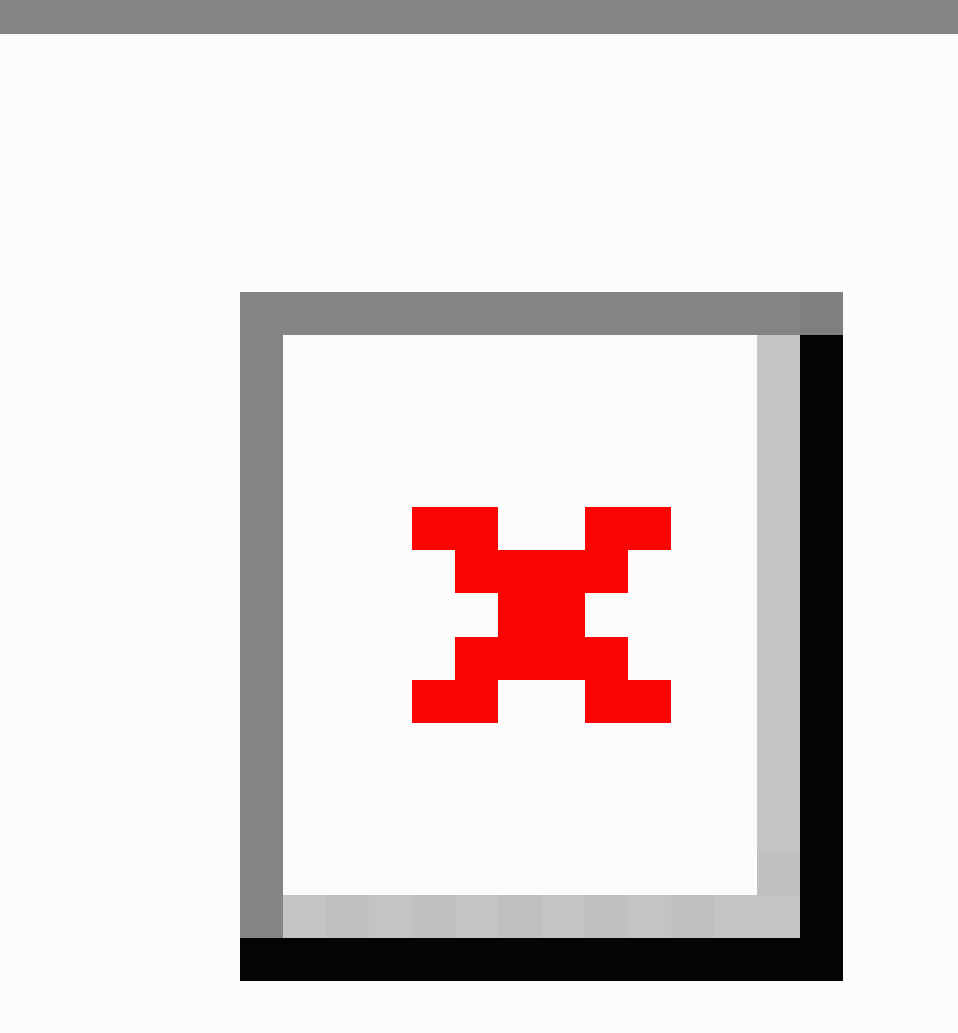
Figure 4. Example screen from OnTrack Diabetes: Consideration of good things about a selected physical